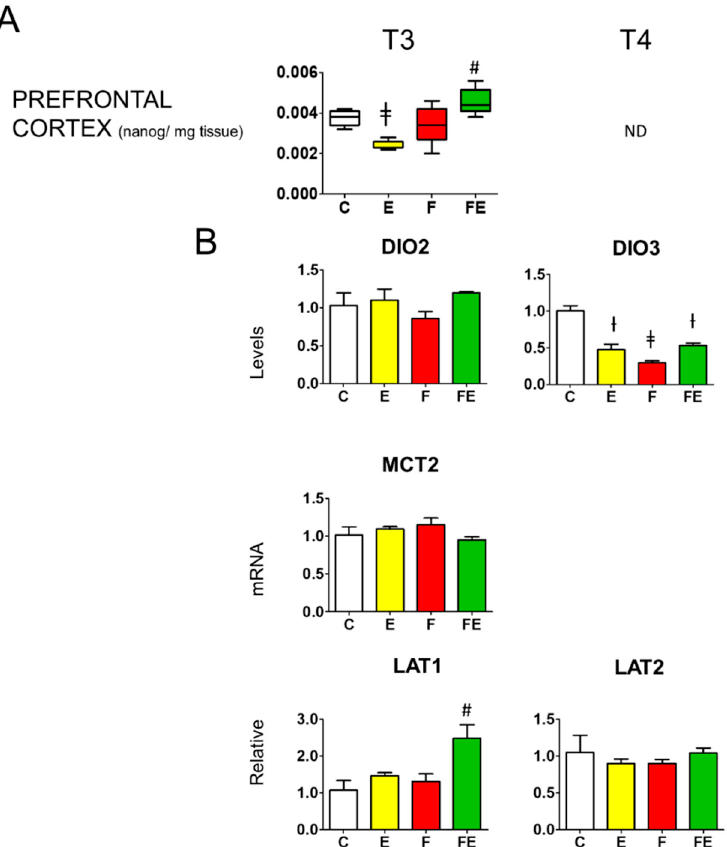
Figure 5. Prefrontal cortex T3 levels and modulation of prefrontal cortex deiodinase 2 and deiodinase 3 mRNA levels, as well as those of BHB transporter MCT2, and amino acid transporters LAT1 and LAT2. ( A ): Mass Spectrometry analysis prefrontal cortex levels of T3; ( B ): Q-PCR analysis of deiodinase 2 and 3, MCT2, LAT1, and LAT2 mRNA levels in the prefrontal cortex. ( A , B ): Analysis was carried out using control rats or rats subjected to exercise, fasting, or fasting with exercise ( N = 4, n = 3). One way ANOVA was carried out followed by a Newman Keuls post-hoc test. † p < 0.05 vs. C and F, ‡ p < 0.05 vs. C, F and FE, # p < 0.05 vs. E, F, and C. Data are shown as means ± SEM.